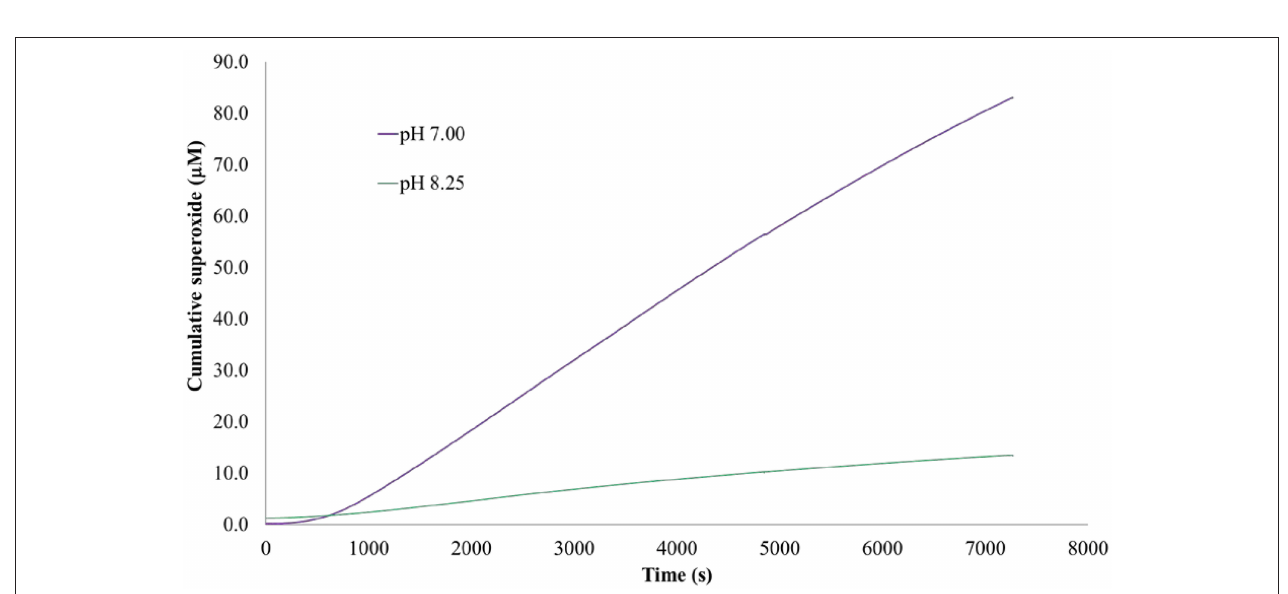
FIGURE 5 | Superoxide formation followed HS − addition. The addition of HS − to 1.00 wt% suspensions of marsh sediments was followed by a rapid increase in superoxide at pH 7.00 and pH 8.25. The apparent stability of superoxide relative to its estimated half-life (max t 1 / 2 ∼ 100 s) indicated continuous generation during the experiment.